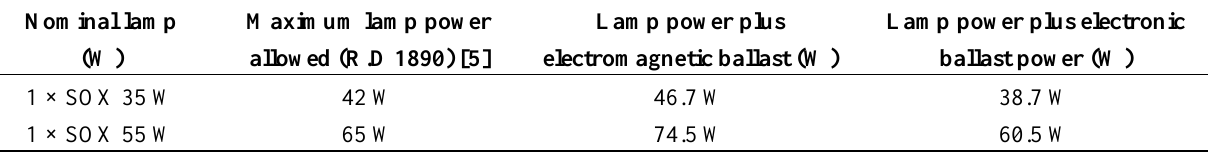
Table 6. Luminaire power for different kind of